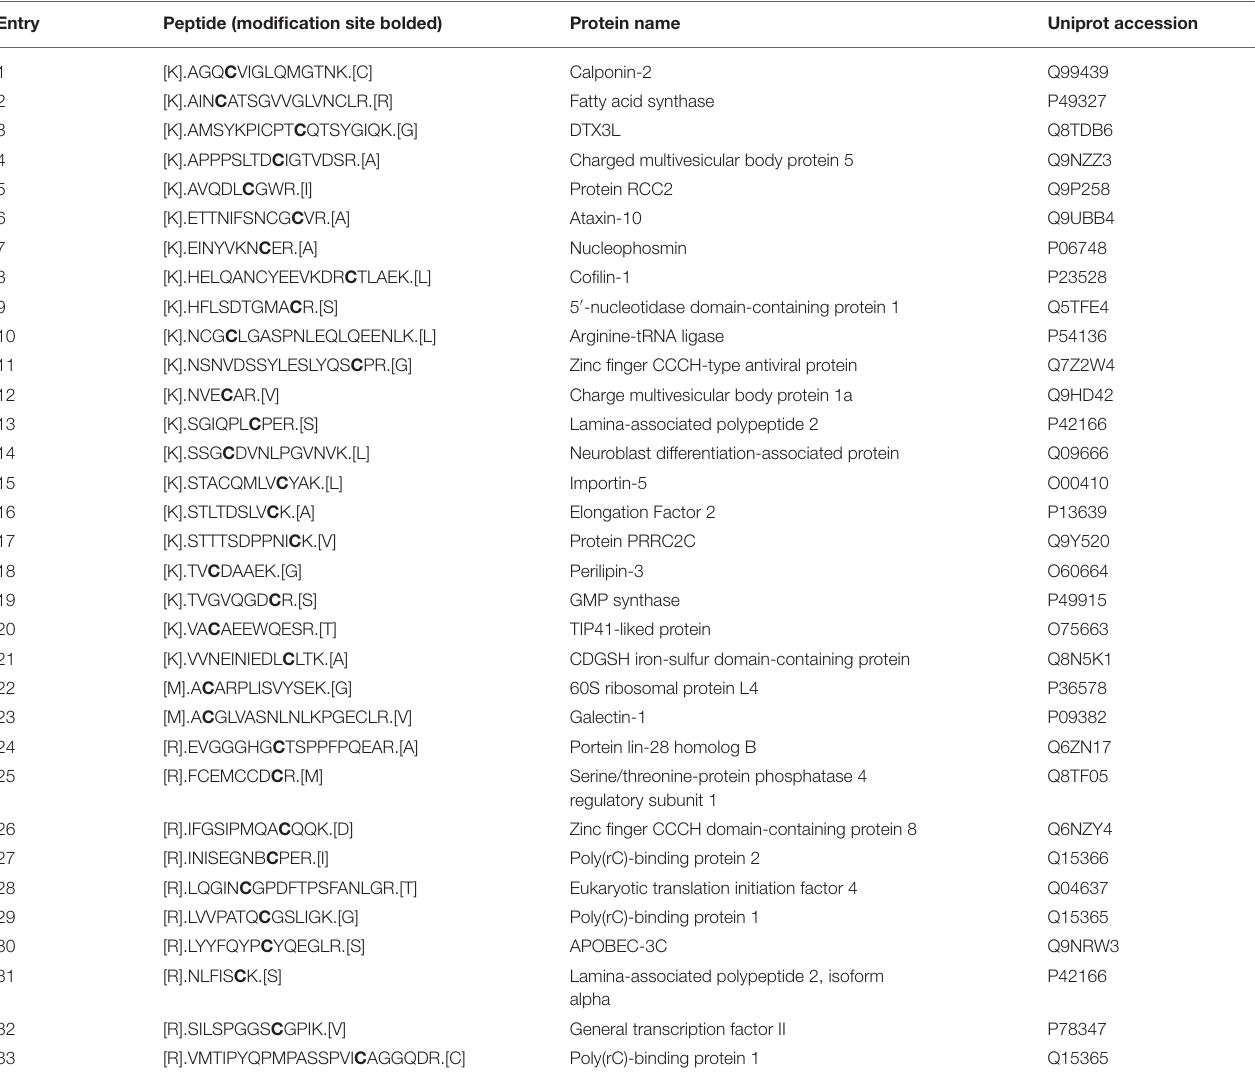
TABLE 1 | 2AzMan-modified